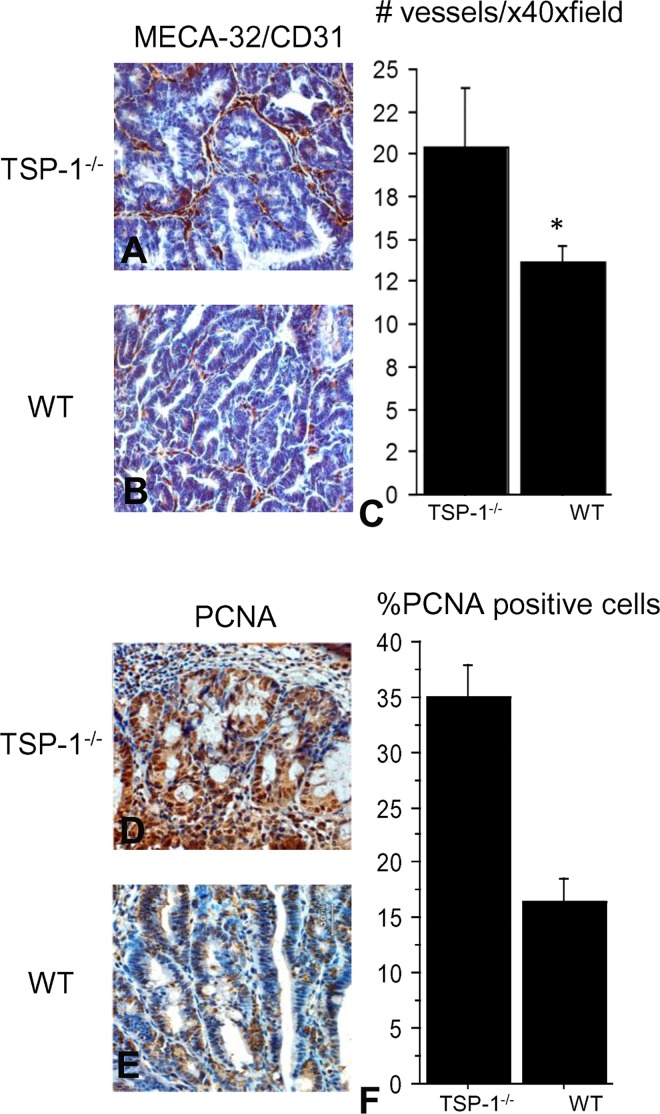
Analysis of microvascular density (MVD) and proliferation in TSP-1-/- and WT tumors.Blood vessels were blindly evaluated in each tumor section stained with MECA and CD31 antibodies in TSP-1-/- (A) and WT colons (B). Tumors lacking TSP-1 showed significantly higher MVD as compared to the MVD in the WT tumors (p = 0.0159), (C). IHC for PCNA was performed and positive nuclei were counted in the tumor sections of TSP-1 deficient mice (D) and WT mice (E). PCNA rates were significantly higher in tumors of TSP-1-/- mice compared to WT tumors (p<.0001), (F).